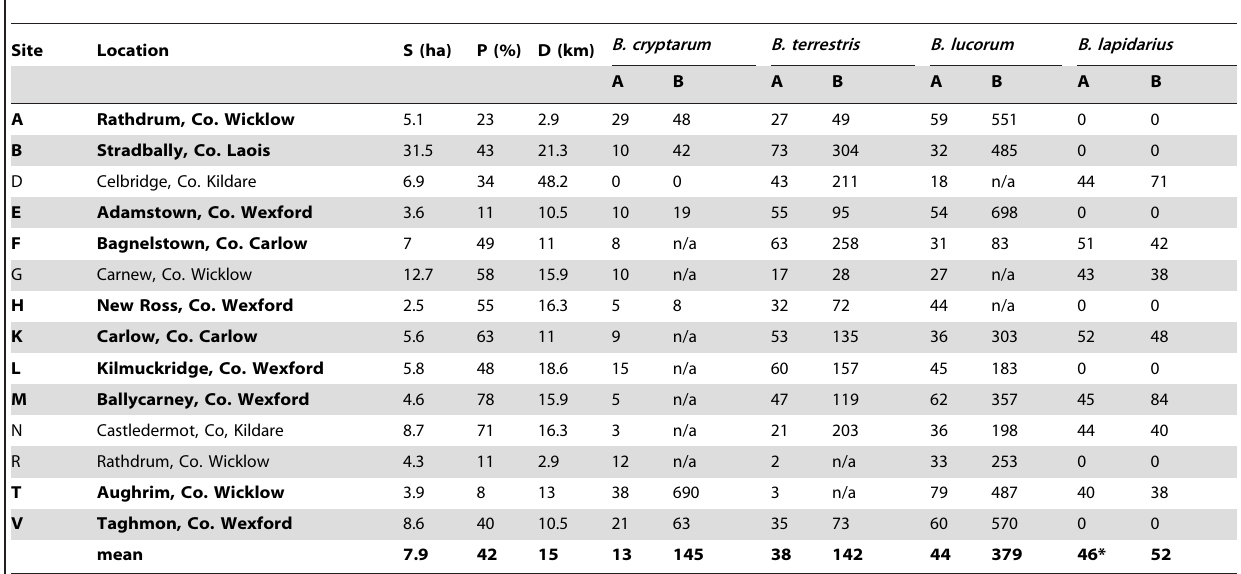
Table 1. Sample sizes (A) and Capwire point estimates of number of colonies (B) of the different bee species in the different sites.